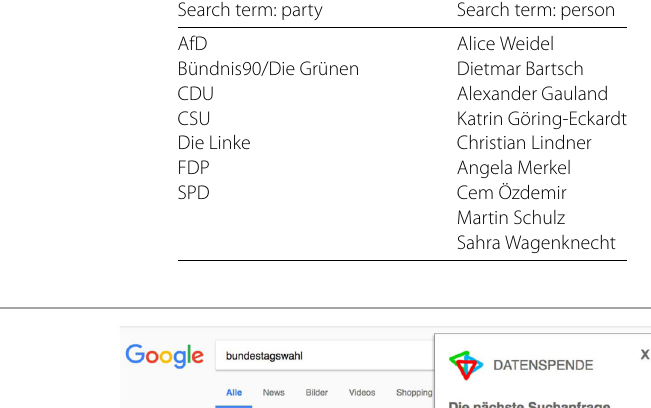
Table 1 All 16 search terms used for the Dataspende project Search term: